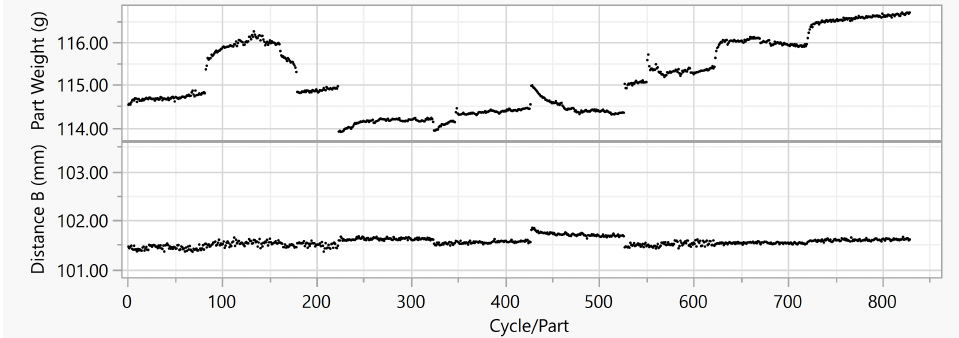
Figure 5. Part weight, Distance B vs. cycle or part in Stacking Box Data Set